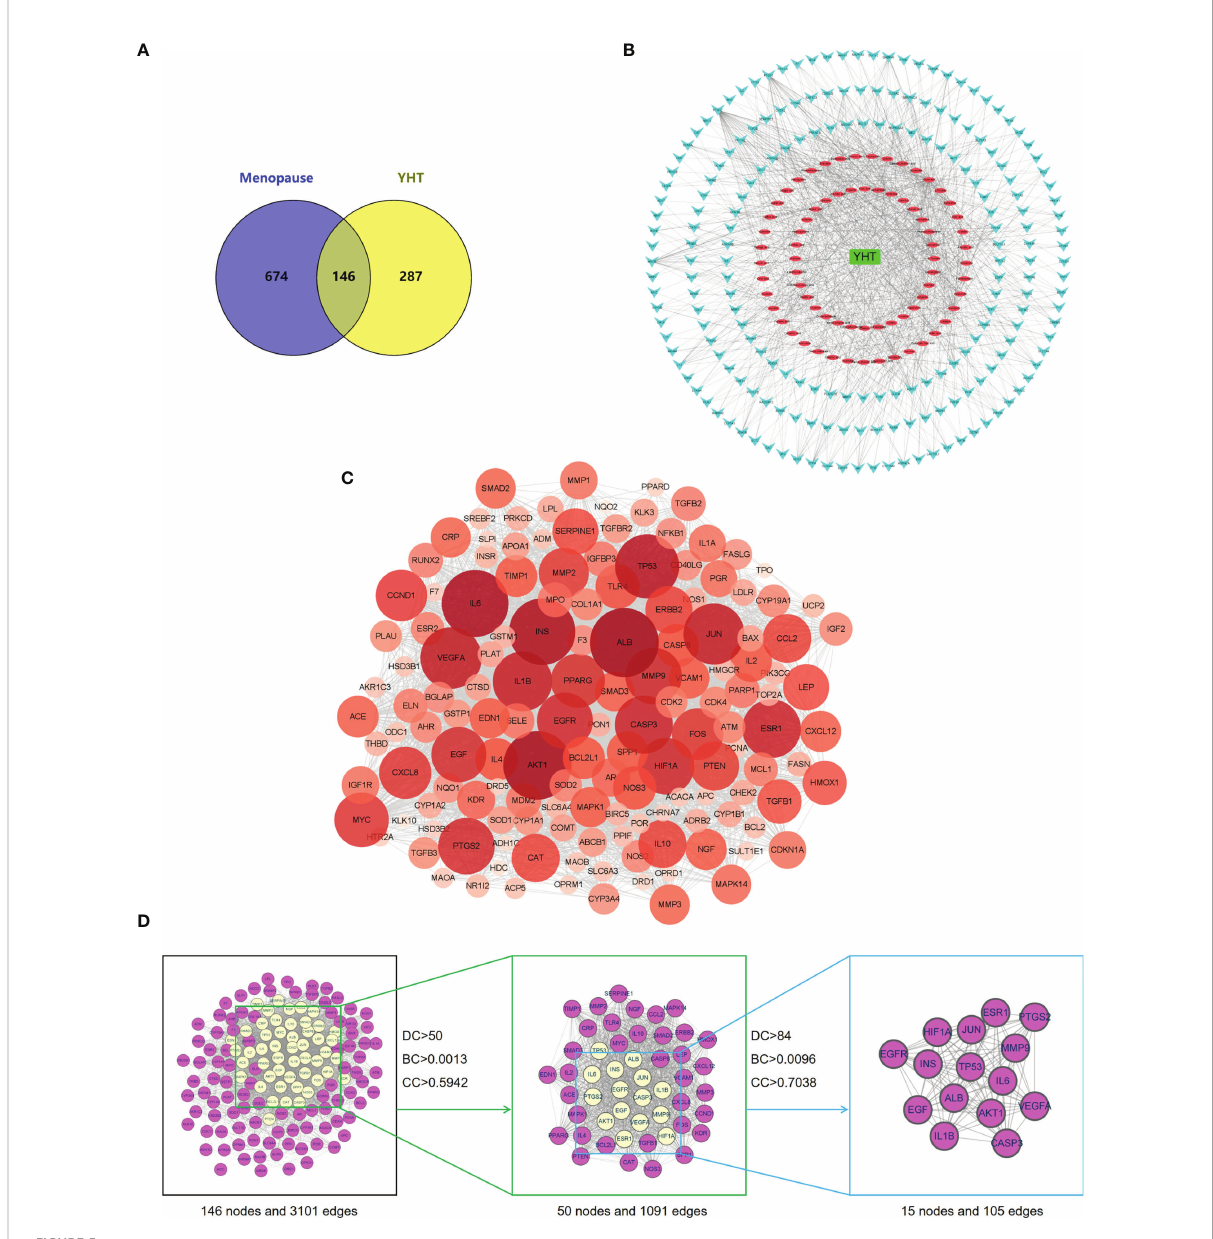
FIGURE 5 The ingredients-targets-disease network and PPI network analyses of YHT. (A) Venn diagram of YHT targets and menopause-related targets. (B) The ingredients-targets-disease network of YHT. (C) The PPI network diagram of targets. (D) The network topology analysis of the PPI